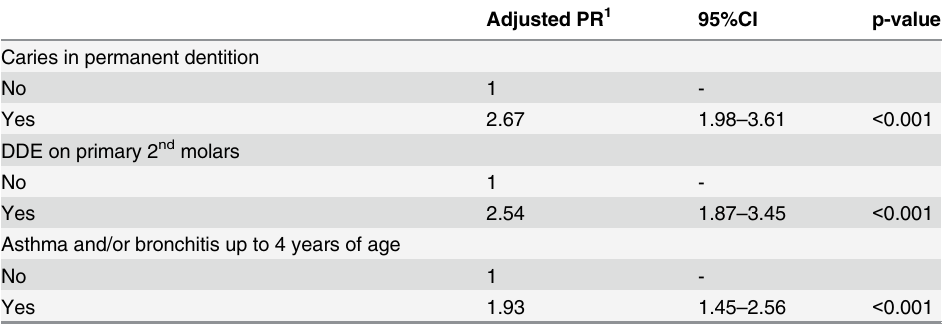
Table 2. Prevalence ratio and confidence interval for associations between MIH and independent vari- ables (n = 1181).